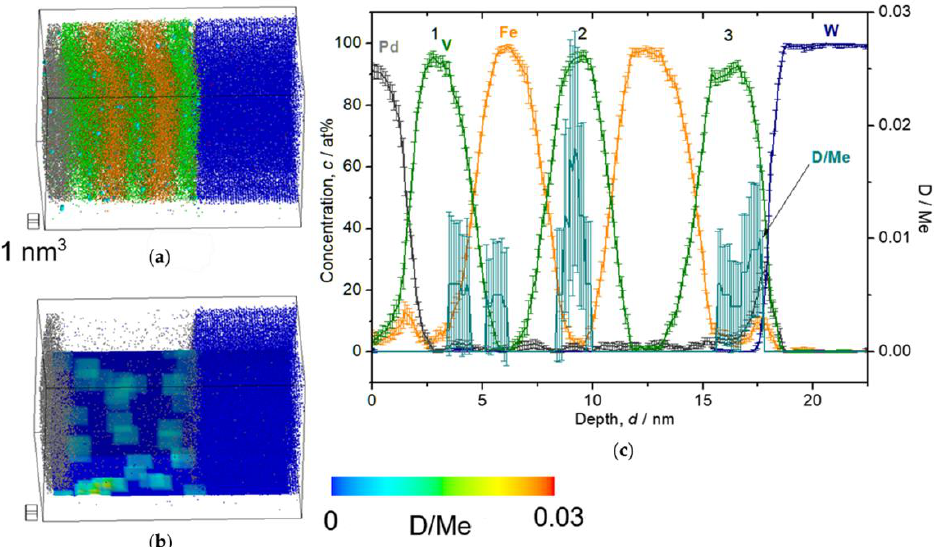
Figure 8. Reconstructed volume of Fe/V multi-layer (14 nm × 14 nm × 27 nm), loaded with D 2 0.05 Pa, analyzed at 30 K. ( a ) The whole volume of reconstruction (grey: Pd, green: V, orange: Fe, blue: W, light blue: D). ( b ) Iso-concentration map of D concentration ( c D = 0.03 D/Me) from the same reconstruction in ( a ). ( c ) Depth concentration profile from 5 nm φ cylinder volume.